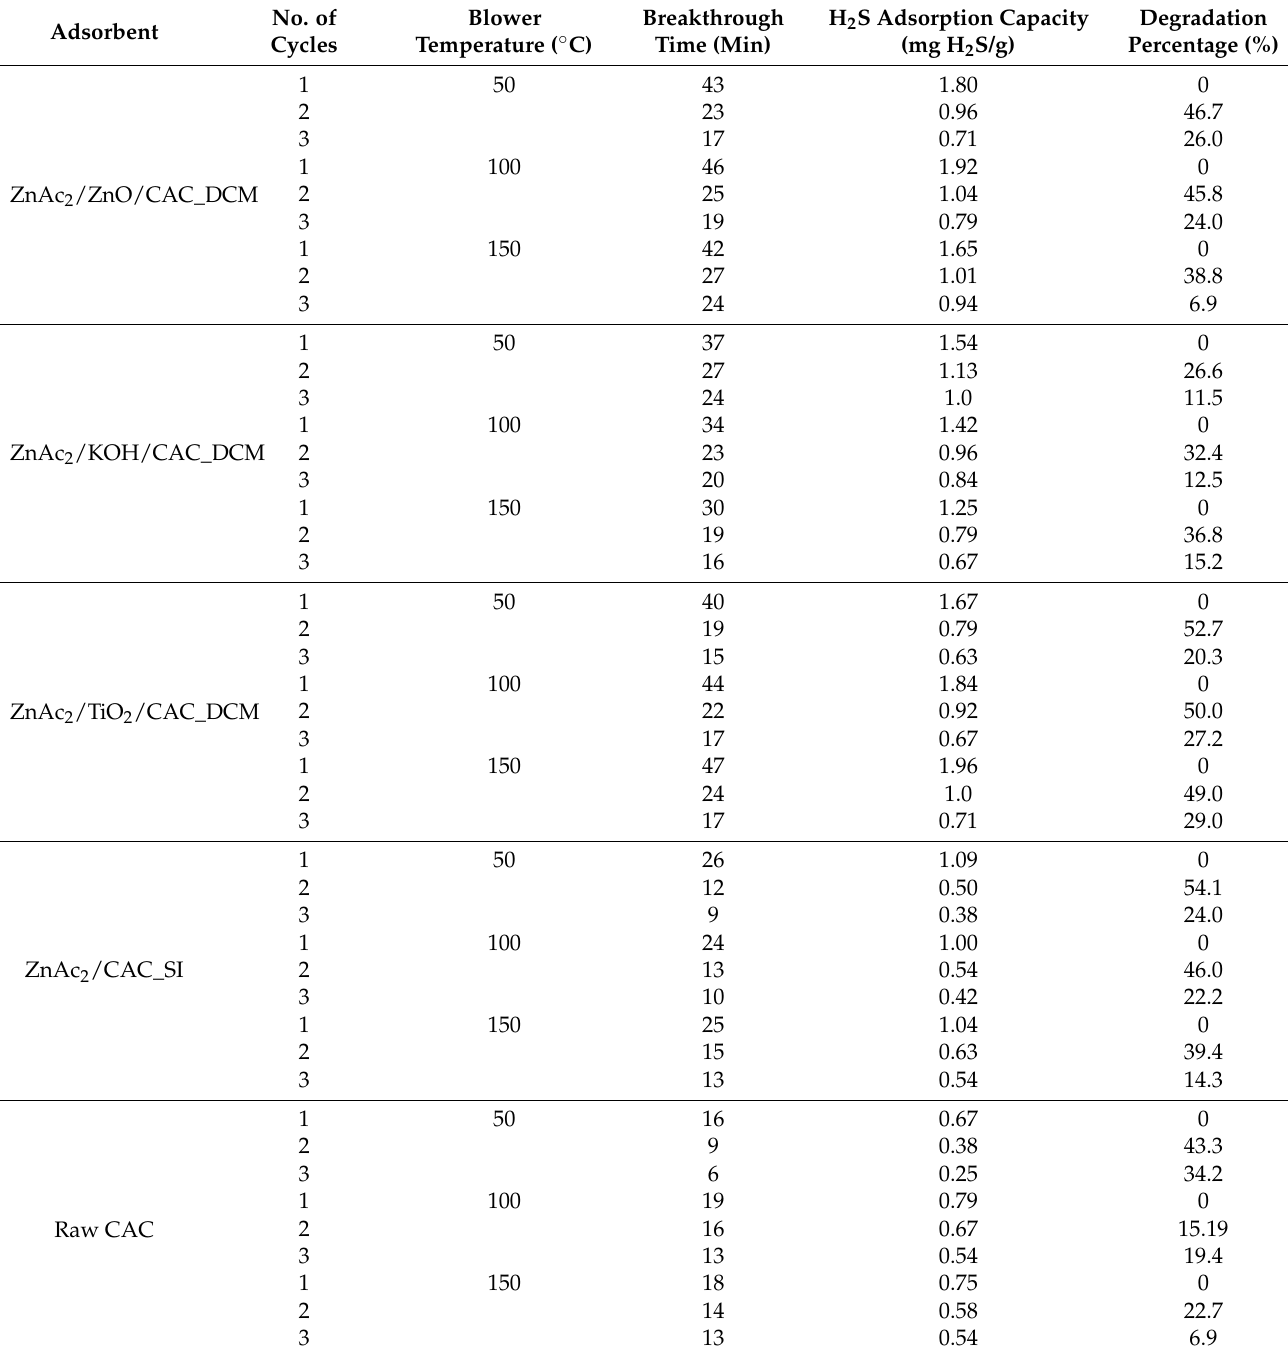
Table 5. Adsorption capacity and degradation percentage for each adsorption–desorption cycle